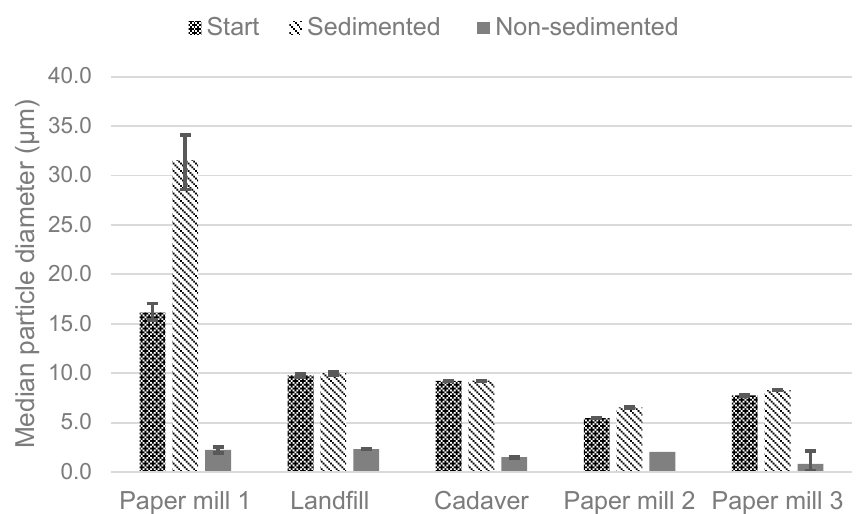
Figure 7. Median particle diameter (Dv50) of samples at the start of sedimentation, the sedimented layer, and the non-sedimented layer.